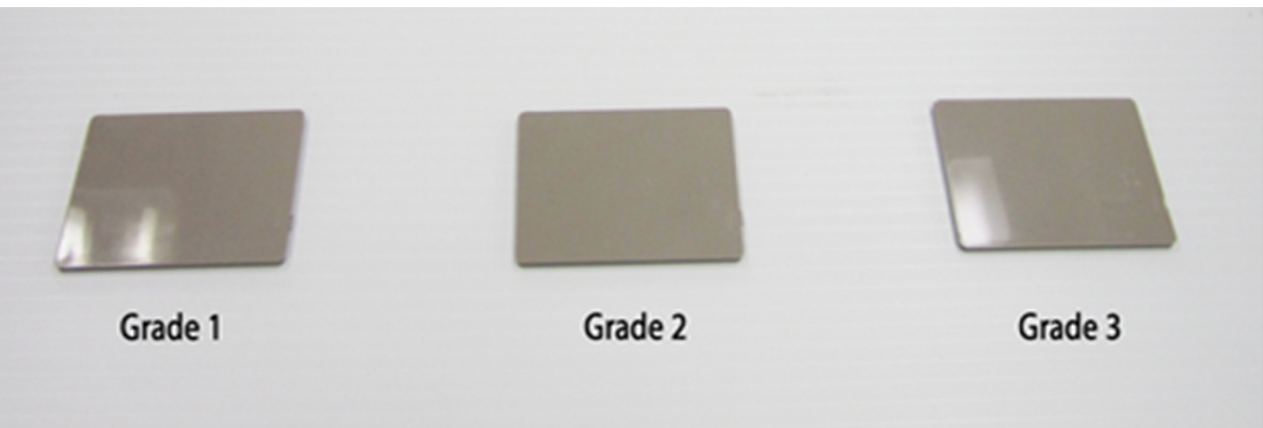
Figure 1. Three grades have different formulations but the same color. Table 1. Compounding formulation used for three grades.